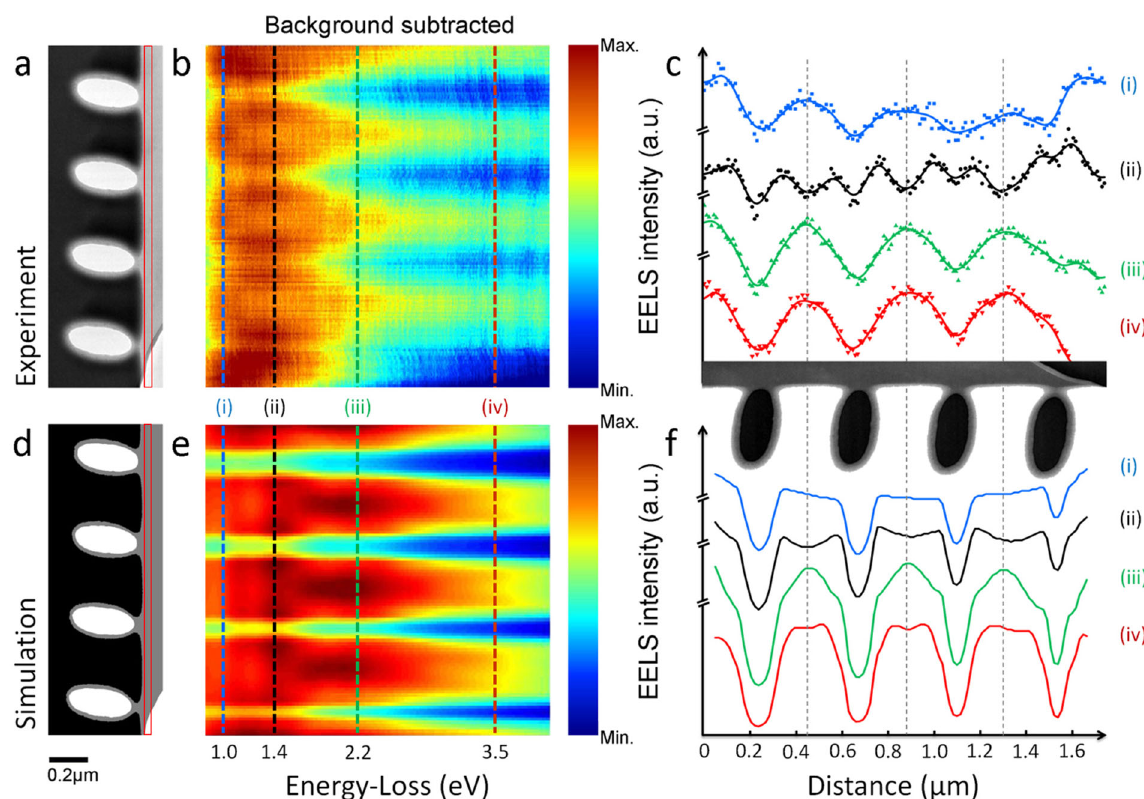
Fig. 4 EELS line scan along a Bi 2 Se 3 edge with a fi nite grating structure. a Bright- fi eld TEM image of the nanostructure. It is composed of an edge with elliptical grooves. The form of the boundaries was extracted as a binary image ( d ) and used for simulations. b , e Experimental and simulated energy- distance maps showing absorption probabilities depending on energy-loss value and probe position were extracted from the area marked with a red box in the survey image. Line pro fi les at selected energies (1.0 eV blue, 1.4 eV black, 2.2 eV green, 3.5 eV red) are shown in ( c ) and ( f ). They are shifted vertically for clarity. The experimental data ( c ) were processed by applying a Fourier transform smoothing algorithm in the plotting software, using a 5-point window (solid